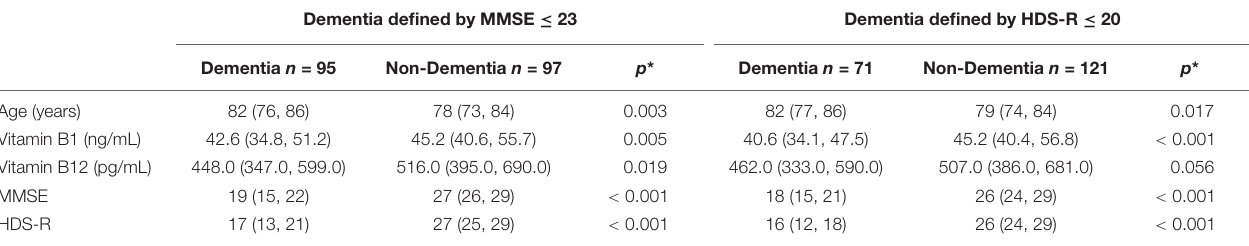
TABLE 2 | Characteristics of dementia and non-dementia group.